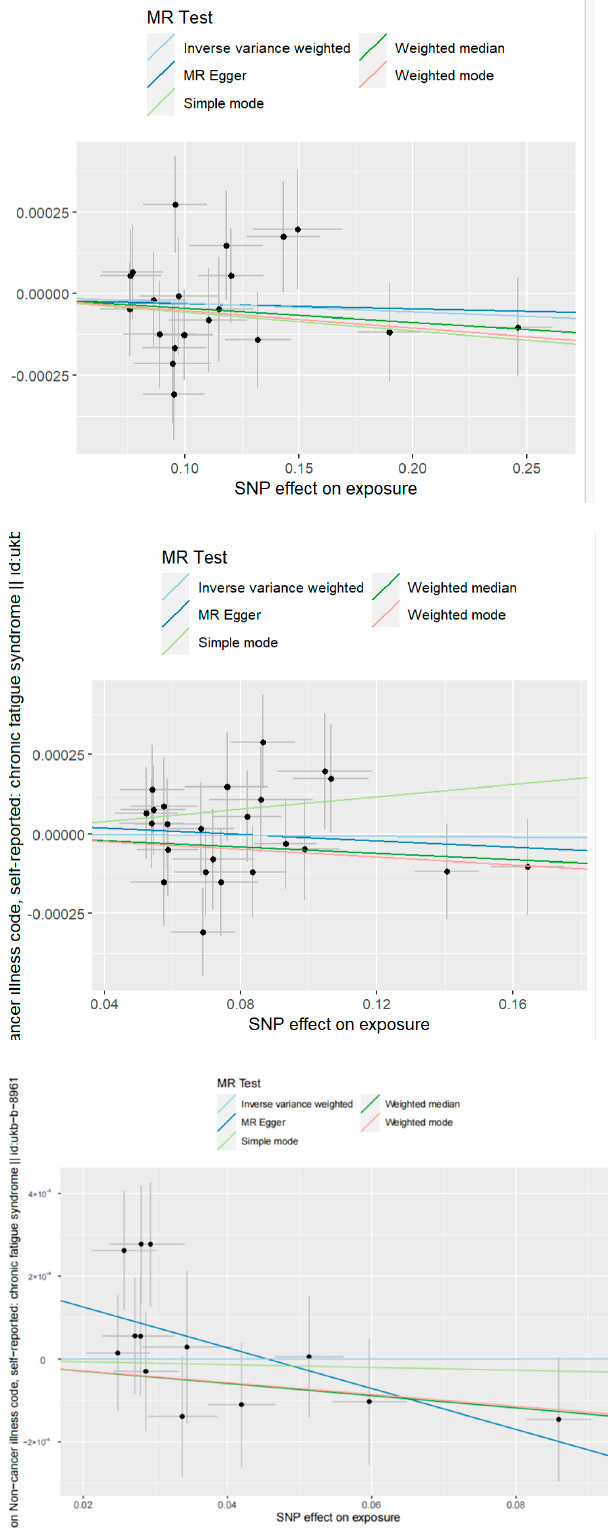
Figure 3. Scatter plots of TSMR Results: severity, hospitalization, and susceptibility.